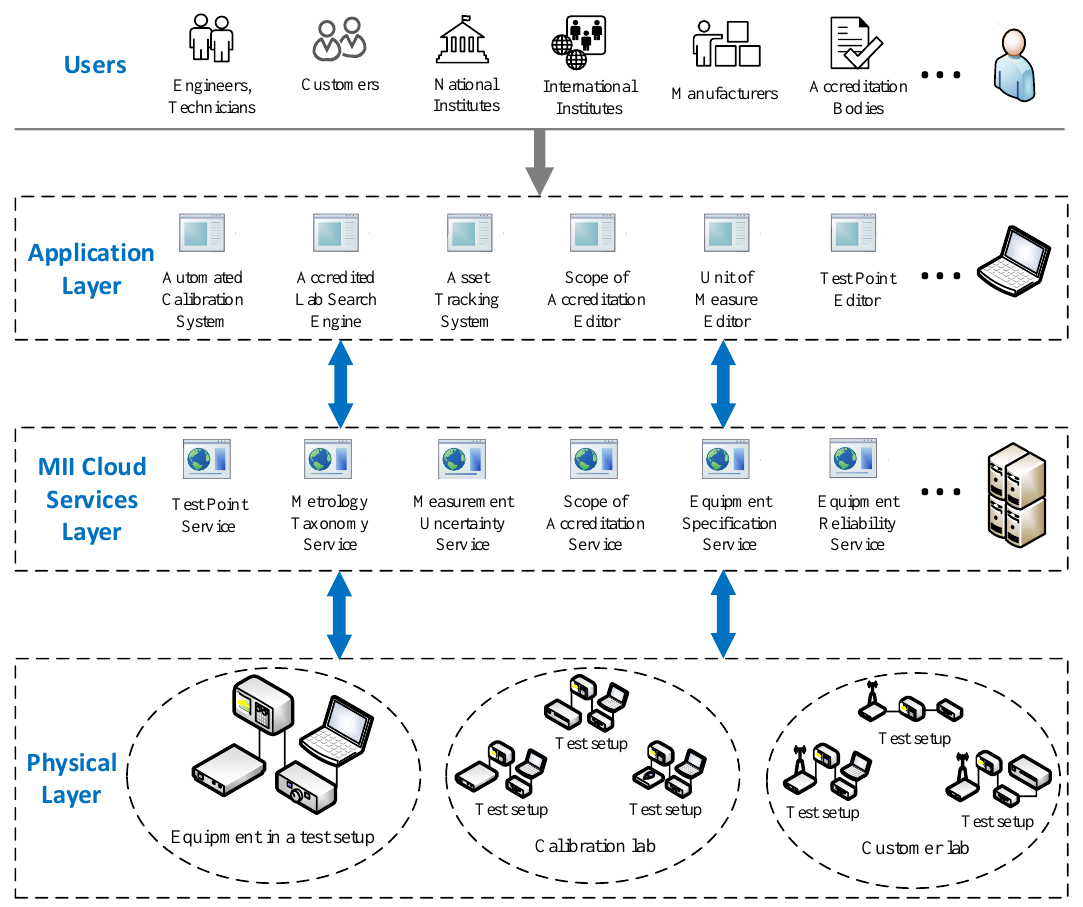
Figure 3: the Physical layer, the MII Cloud Services layer, and the Application layer. This layered model conforms to the reference architecture for IIoT proposed by Industrial Internet Consortium (IIC) [28].